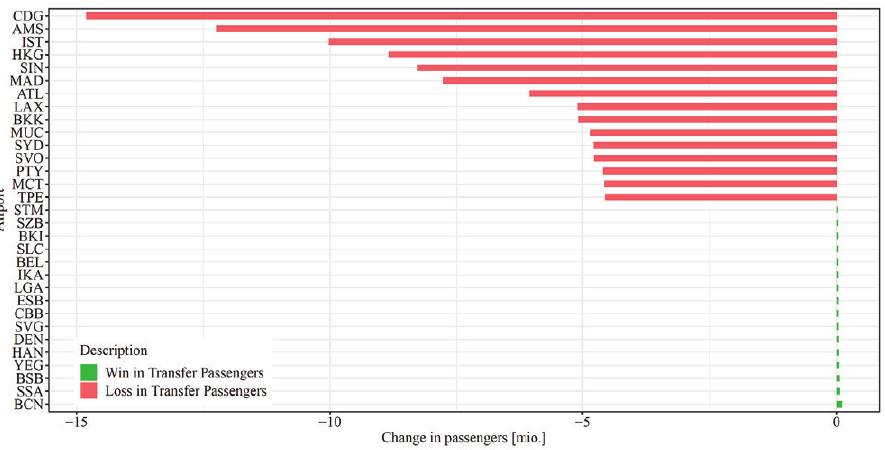
Figure 9. Top 15 decrease and increase in passenger numbers at worldwide airports through